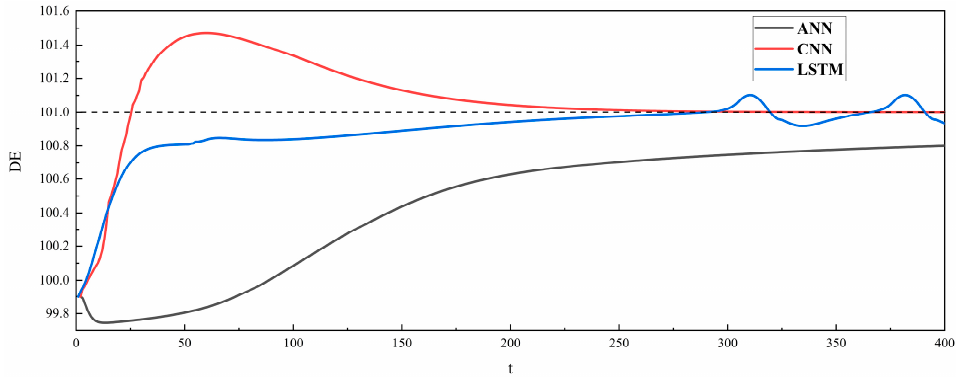
Figure 10. The state pro fi les of di ff erent neural network models.